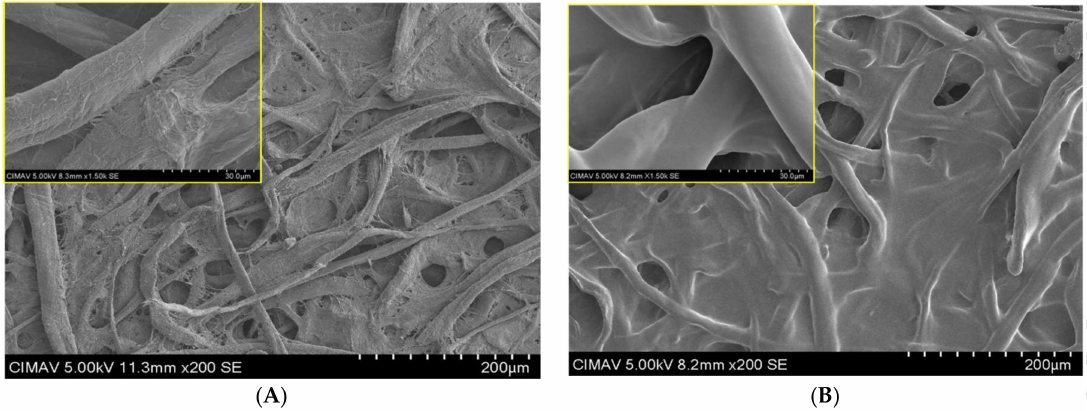
Figure 2. SEM images of the modified paper-based sensor prior to ( A ) and after chitosan modification ( B ) at 2% ( m / v